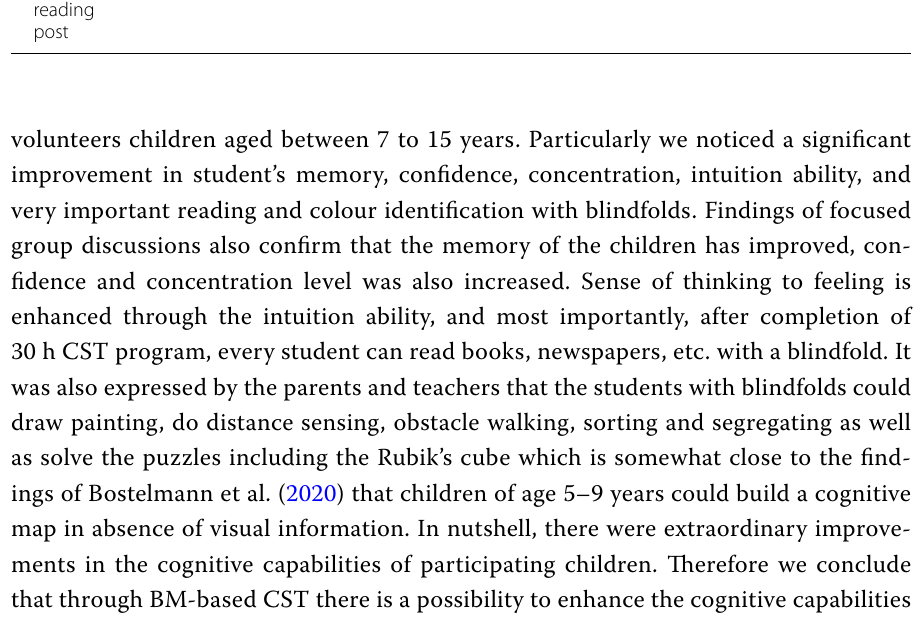
Table 10 Paired samples test: blindfold reading/colour identification. Source: SPSS 23.0 output Paired differences t df Sig. (2-tailed) Results Mean SD SE mean 95% Confidence interval of the difference Lower Upper Pair